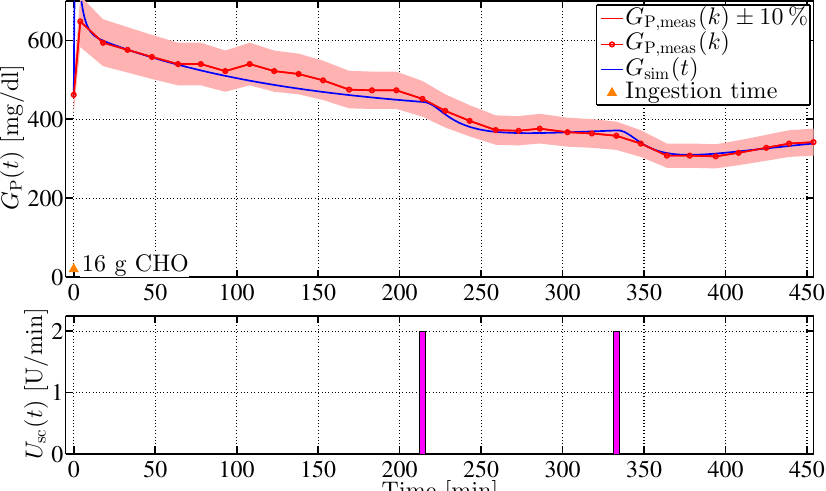
Figure 7. Comparison of minipig #4 in vivo measurements to in silico results of the identification procedure with individualised Göttingen Minipig data set. The orange triangle indicates a carbohydrate (CHO) uptake of 16 g a the beginning of the experiment. Indicated in the figure is a ± 10% confidence interval by the red